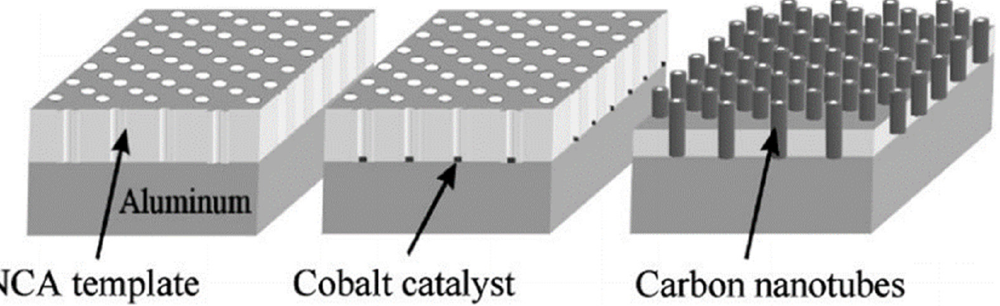
Figure 2. ESEM image of aligned MWCNT patterned arrays showing the effect of alignment with the grown time: ( a ) half hour, top view (scale 1 mm); ( b ) half hour, side view (scale 100 μ m); ( c ) 3 h, side view (scale 100 μ m) [46]. Copyright 2006, American Chemical Society.